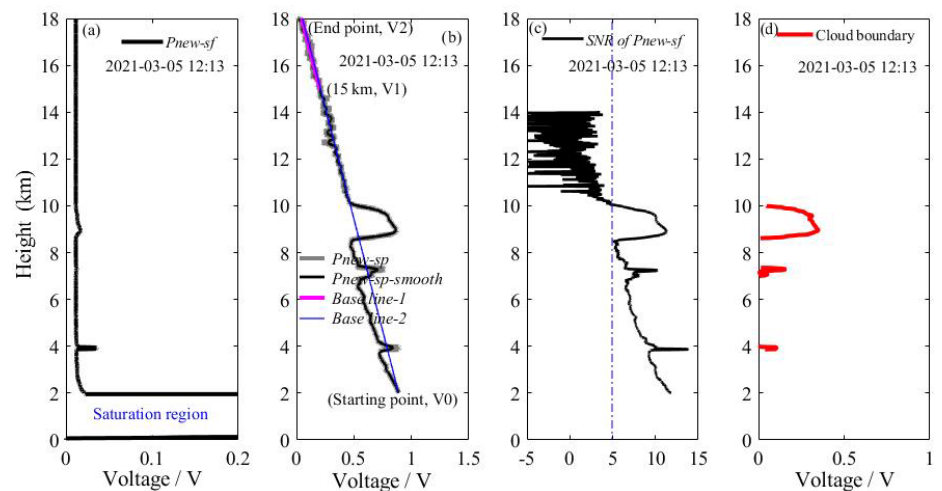
Figure 3. Detection results of lidar at 12:13CST on 5 March 2021. (a) P new_sf of the 1064nm signal, (b) P new_sp of the 1064nm signal, (c) SNR of P new_sf , and (d) cloud information detected.